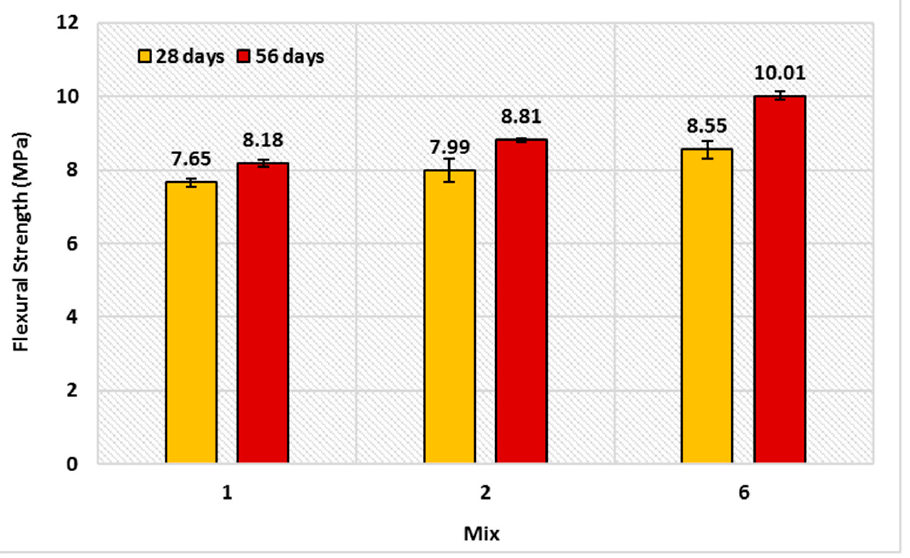
Figure 7. Effect of SF and MW on concrete flexural strength.